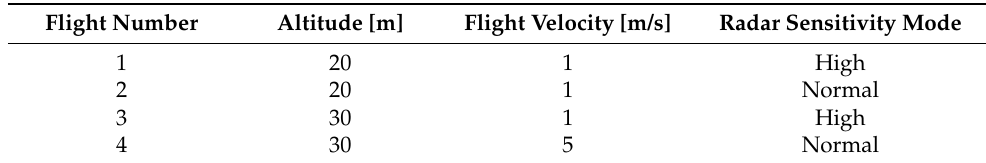
Table 3. Flight parameters of four flights to evaluate the data processing. Flight Number Altitude [m] Flight Velocity